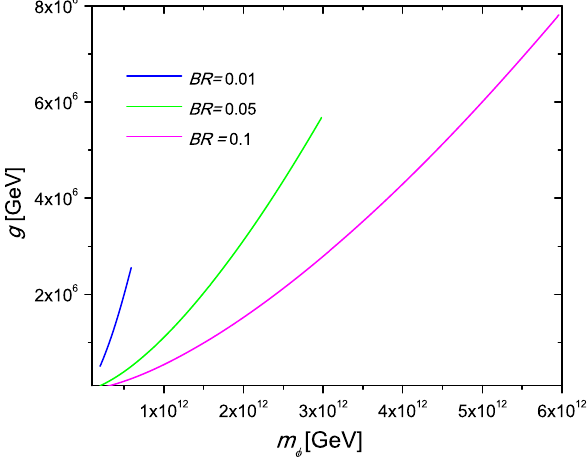
Fig. 2 Yukawa coupling y 1 versus the inflaton mass m φ in GeV for three different values of the branching ratio, 0.01 (blue), 0.05 (green) and 0.1